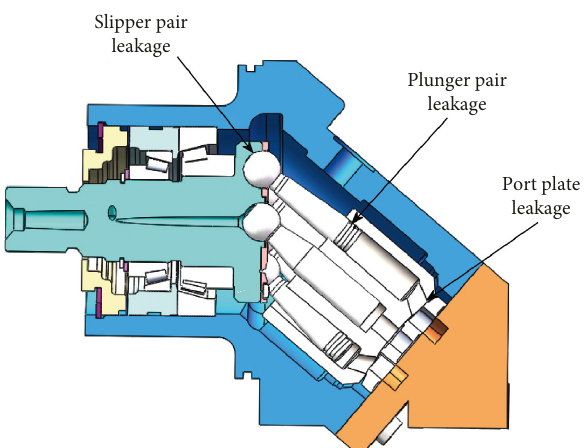
Figure 3: Internal leakage diagram of the axial piston motor.